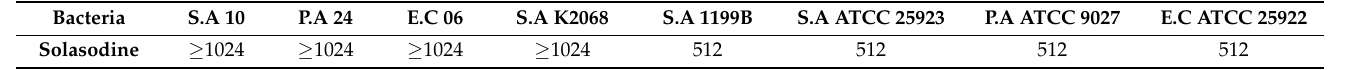
Table 1. Determination of the minimum inhibitory concentration ( µ